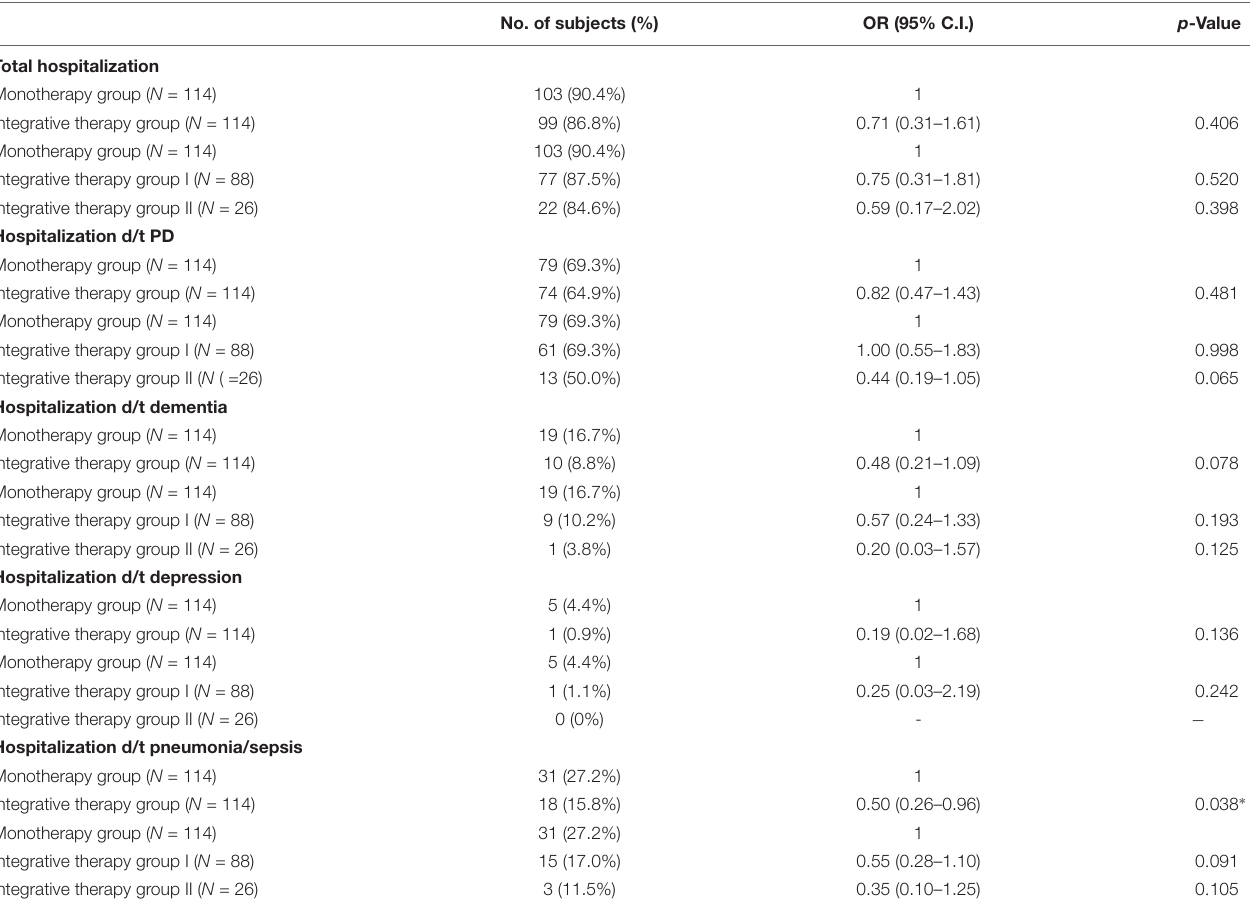
TABLE 2 | Comparison of prevalence of hospitalization between integrative therapy group and monotherapy group (unit: no. of subjects). No. of subjects (%) OR (95%